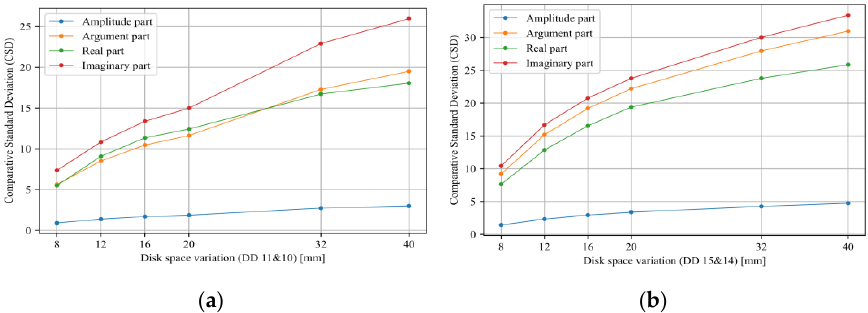
Figure 12. Feature variations based on the severity of the DSV fault in different locations for extracted by the CSD index: ( a ) DSV in DD 11 and 10 ( b ) DSV in DD 15 and 14.